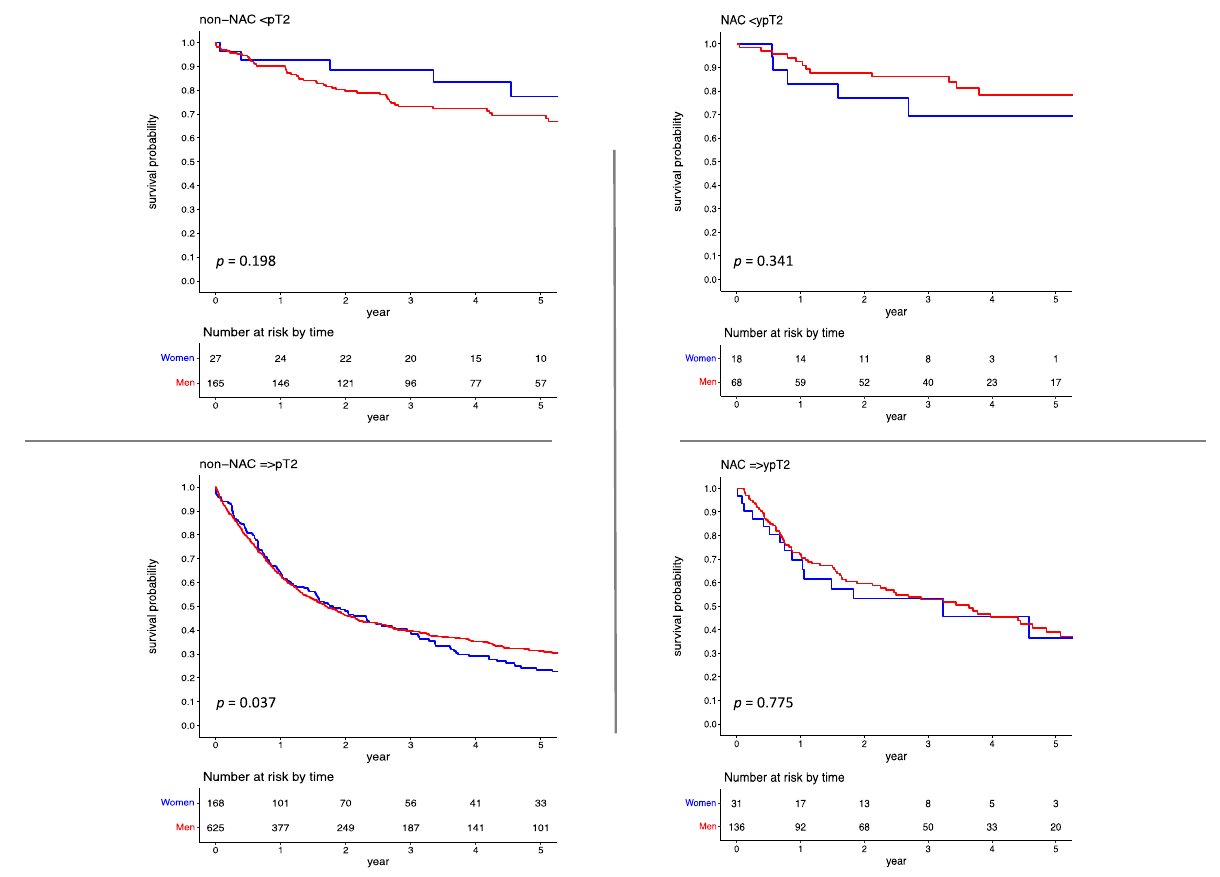
Figure 2. Kaplan–Meier analysis of overall survival in chemotherapy-naïve and chemotherapy pre-treated patients who underwent radical cystectomy stratified according to tumor stage. Table 3. Impact of female sex on overall survival in univariable, multivariable and propensity- weighted regression analysis stratified by pT stage and receipt of neoadjuvant